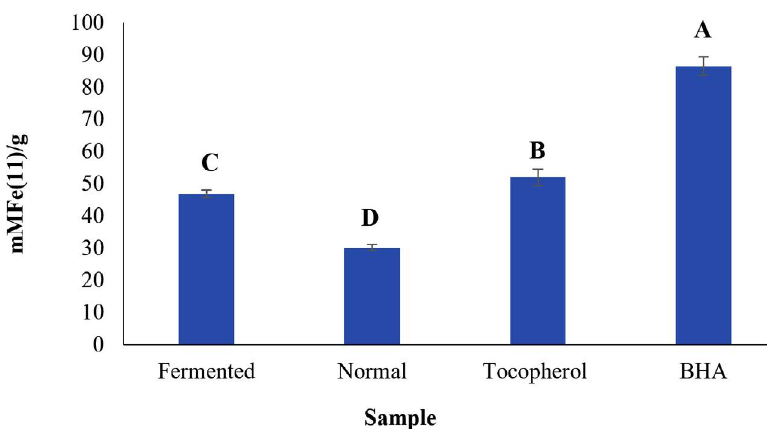
Fig. 2. FRAP ferric reducing antioxidant power of the fermented and normal Cyperus rotundus extract Mean of with the same letters are not significantly different at p >